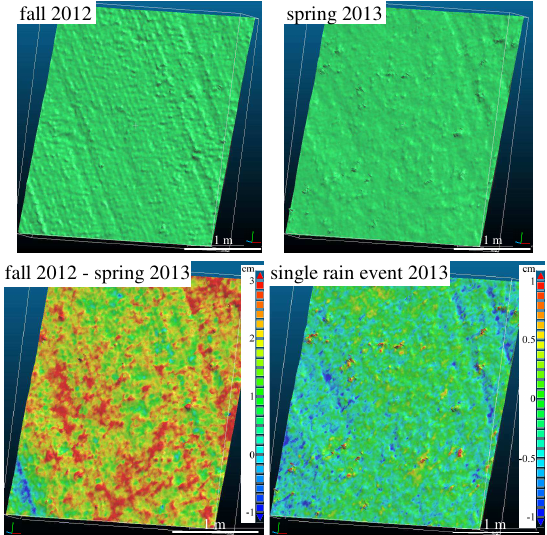
Figure 7. Change detection at the Andalusian plot, unit